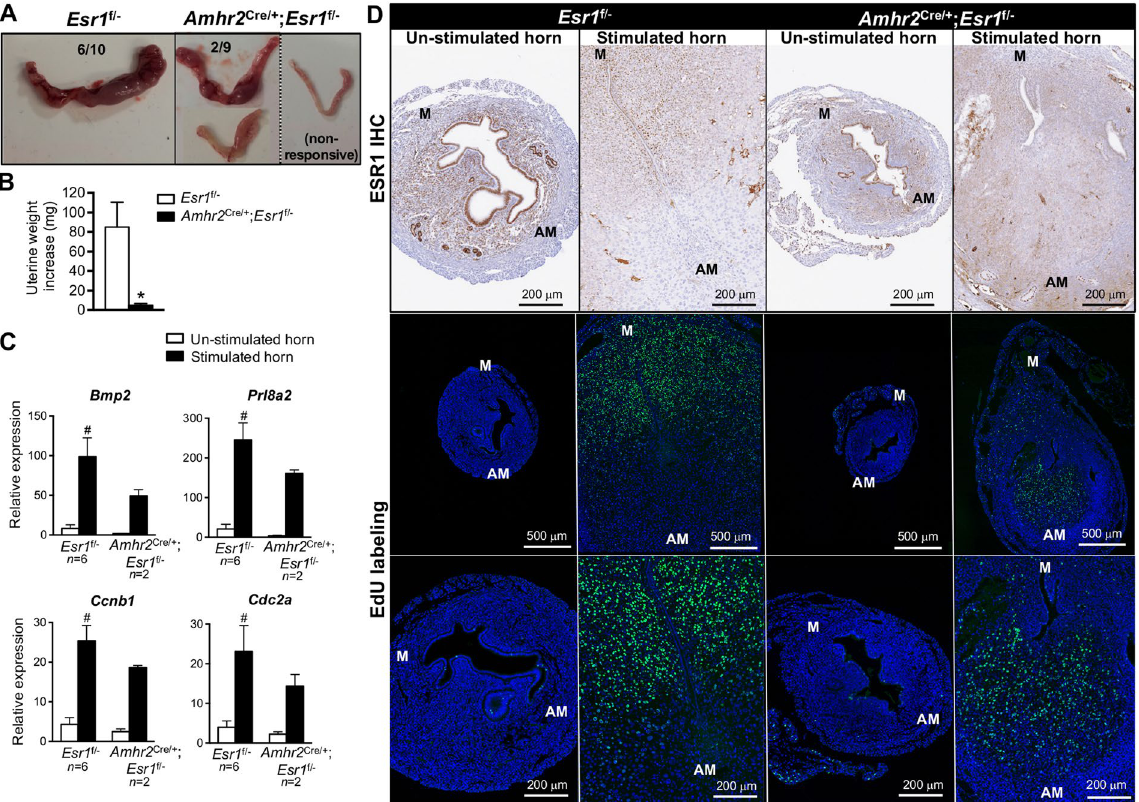
Figure 7. Impaired decidual response to artificial stimulation in the absence of stromal ESR1 in the anti- mesometrium. Artificial stimulation was used to induce decidual response in adult (8–12-week-old) Esr1 f/ − and Amhr2 Cre/ + ; Esr1 f/ − female mice (details for the treatment regime are described in Methods). ( A ) Gross morphology of uteri showing un-stimulated vs. stimulated uterine horns. Data below indicate the numbers of animals responding to the stimulation in Esr1 f/ − (6/10) or Amhr2 Cre/ + ; Esr1 f/ − (2/9) animals. Non-responsive Amhr2 Cre/ + ; Esr1 f/ − uteri (7/9) are also shown. ( B ) Uterine weight increased in the stimulated horns compared to un-stimulated horns (N = 9–10 animals/group). * p < 0.05, significant difference, unpaired t -test. ( C ) Transcript levels of decidual markers and cell-cycle regulators ( Bmp2 , Prl8a2 , Ccnb1 , and Cdc2a ) in Esr1 f/ − (N = 6 of 10 animals) vs. Amhr2 Cre/ + ; Esr1 f/ − (N = 2 of 9 animals) uteri that responded to artificial stimulation. # p < 0.05, significant difference between un-stimulated and stimulated horns within genotype, unpaired t -test. All graphs represent mean ± SEM. ( D ) Uterine cross-section of Esr1 f/ − and Amhr2 Cre/ + ; Esr1 f/ − mice after artificial stimulation. Images illustrate ESR1 IHC and EdU incorporation assay in un-stimulated and stimulated horns. Green indicates cells in S-phase of DNA synthesis. Blue represents Hoescht stained